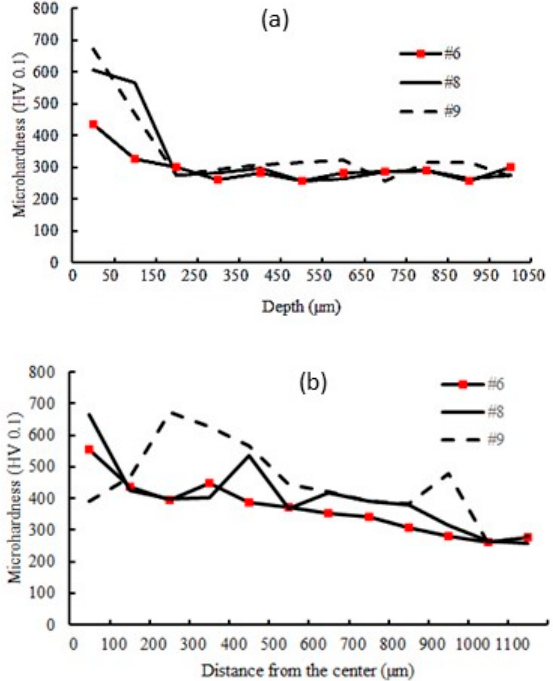
Figure 9. Micro-hardness profile in ( a ) depth and ( b ) width of the hardened laser layer (samples #6, #8, and #9 different LSS).